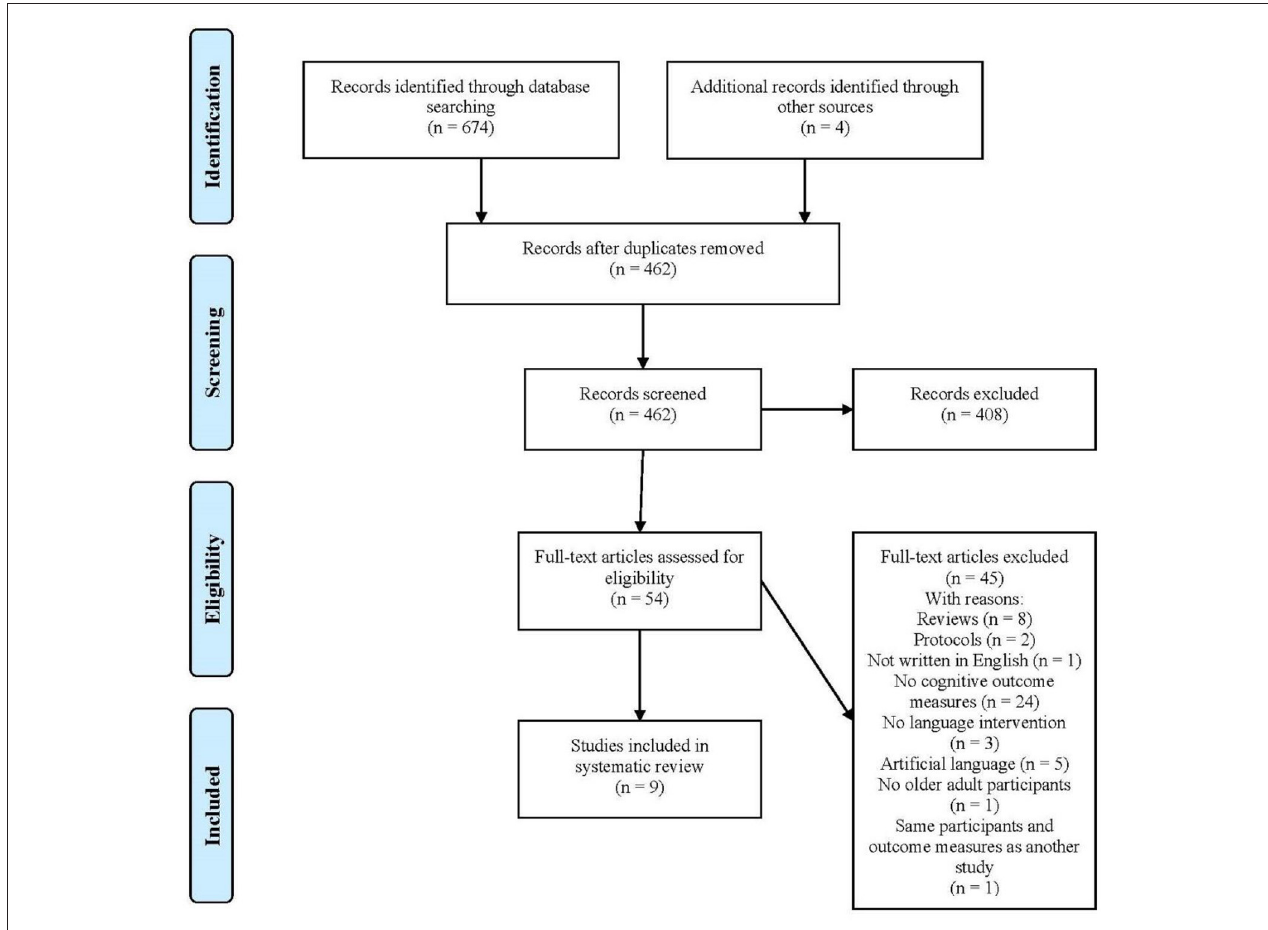
FIGURE 1 | Prisma